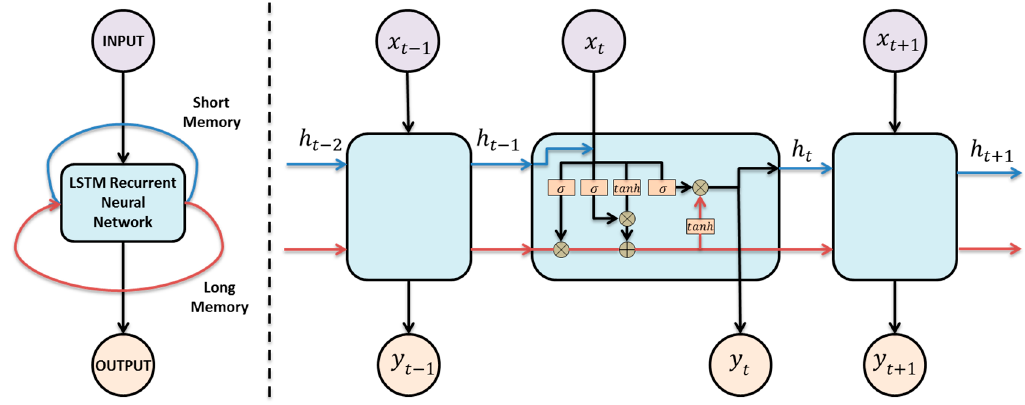
Figure 4. The structure of long short term memory (LSTM) model.